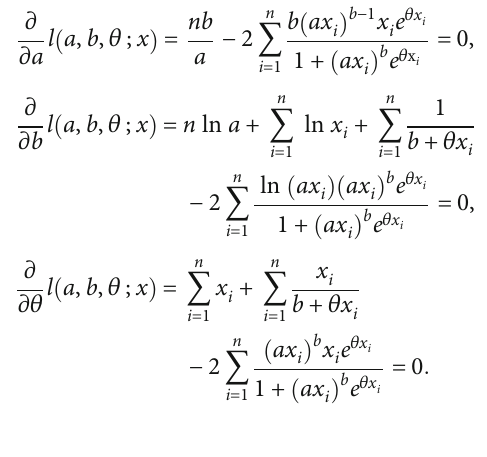
and MSE in the fi rst row, B and a a b